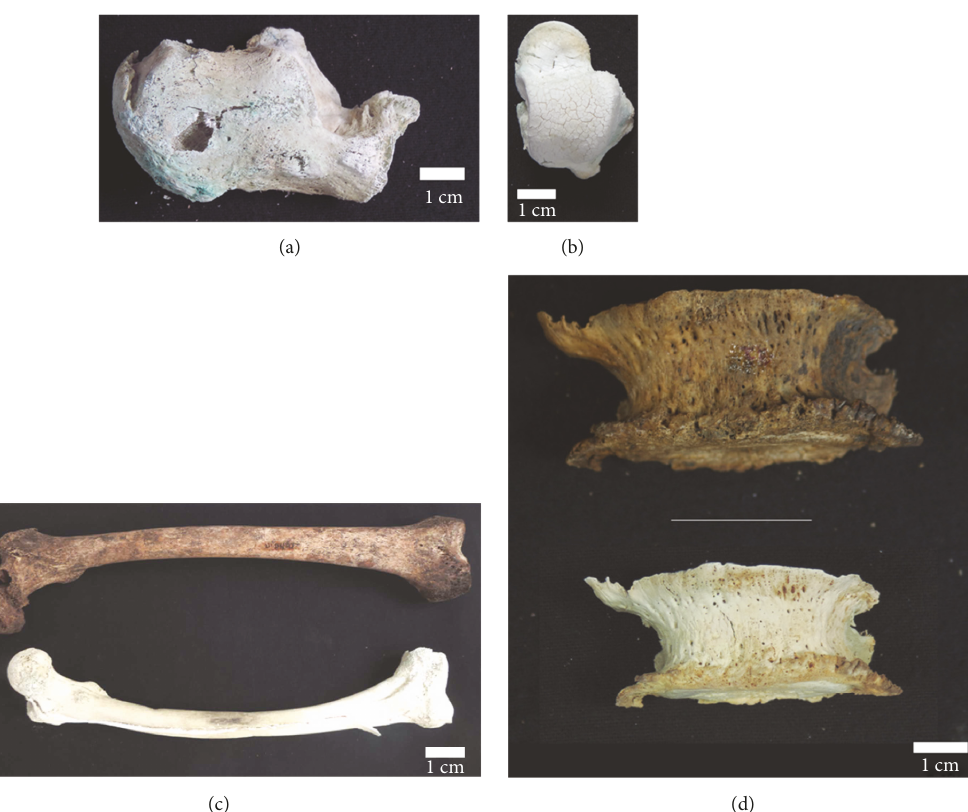
Figure 1: Four examples of burned bones used in this study: (a) CC/NI/16, left calcaneus; (b) CC/NI/17, left talus; (c) CC/NI/16, comparison between unburned right femur and burned left femur; and (d) CC/NI/18, comparison between unburned and burned thoracic vertebra. The burned vertebra was a ff ected by heat-induced shrinkage, thus explaining its substantial smaller size in comparison to the unburned